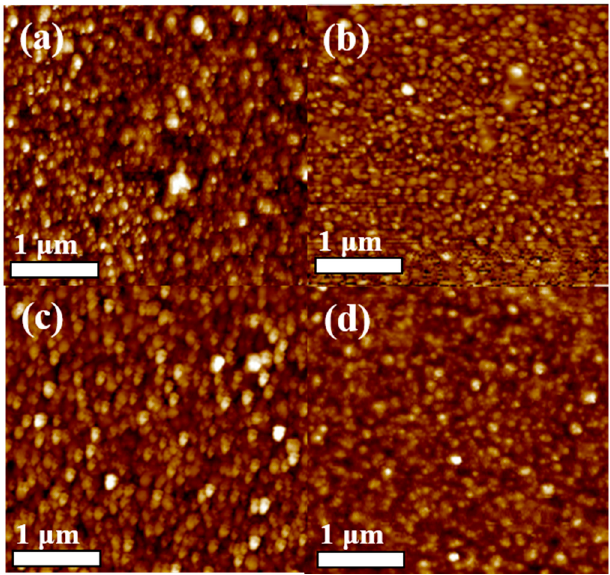
Figure 8. The surface roughness of samples series (II), FePt(6 nm)(Ag, C)(x vol %) / [MgTiTaON(1 nm) / FePt(4 nm)(Ag, C)(x vol %)] 2 films, ( a ) 2.38 nm; ( b ) 4.16 nm; ( c ) 5.28 nm and ( d ) 3.25 for (Ag, C), x = 10, 20, 30, 40 vol %, respectively.